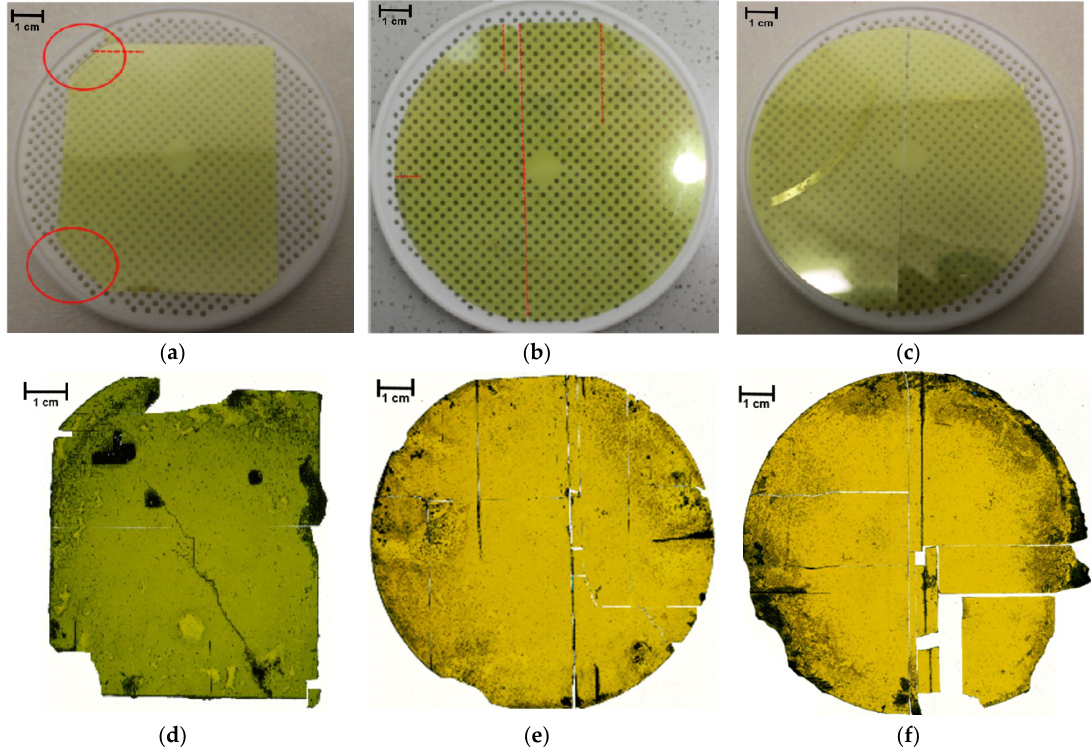
Figure 3. Free-standing epitaxial layers cut out of a four inch wafer increasing the diameter of the grown samples. ( a ) Features of some edge areas of the wafer at the corners circled in red. Cracks started to propagate from such edge areas. ( b ) The epitaxial layer was removed from the edge areas, and cracks propagated on the flat areas. ( c ) Reduction to a 95 mm diameter without edge or flat areas resulted in a single crack generated by uplifting during etching. The corresponding crystals grown on the shown free-standing epitaxial layers are depicted in ( d – f ). All samples feature additional cracks introduced by the post-process removal from the carrier due to polycrystalline growth at the borders. The thicknesses of the samples varied between 480 µm to 520 µm, with growth rates between 180 µm/h and 320 µm/h.